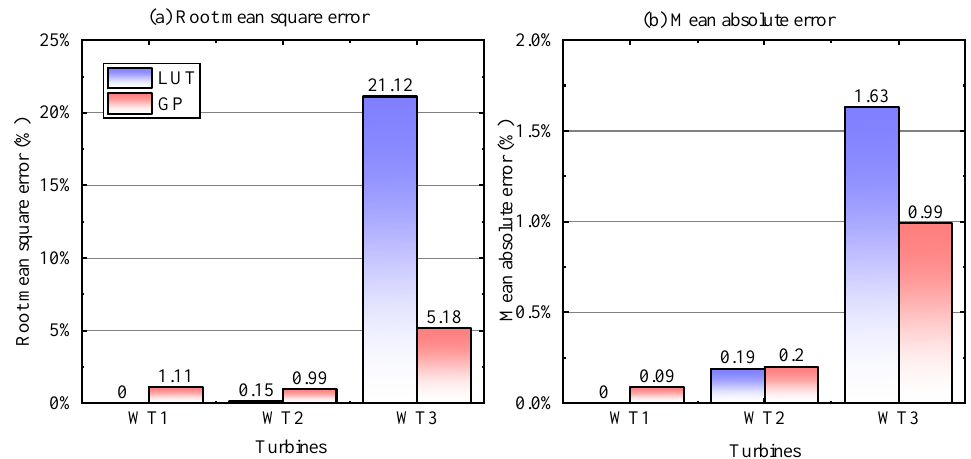
Figure 16. RMSE and MAE error of GP and LUT predictions on blade root edgewise moment.